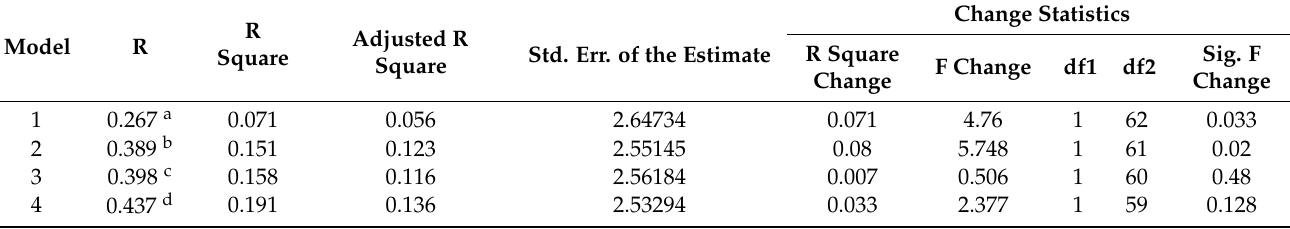
Table 3. Multivariate analysis of corneal biomechanical